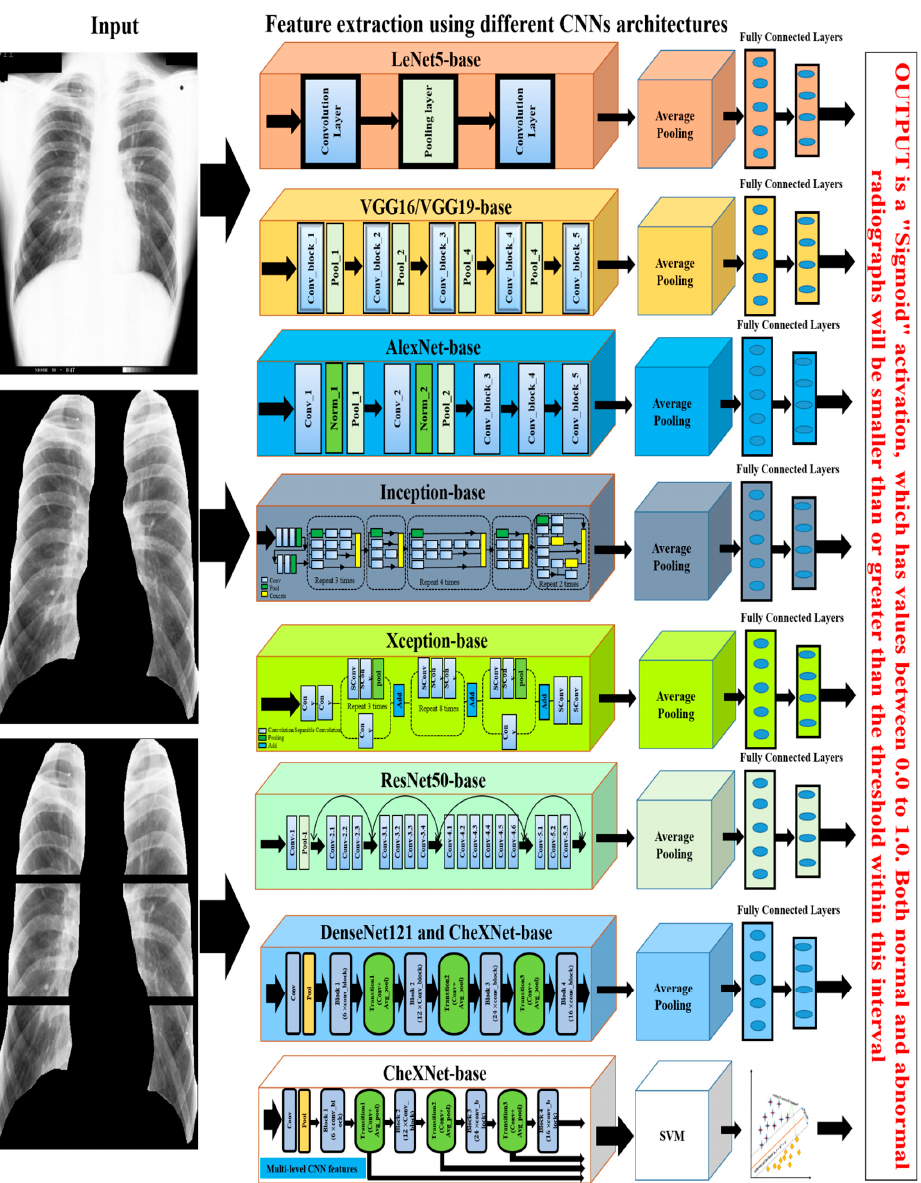
Figure 6. The illustration of the deep learning approaches used for CWP detection.